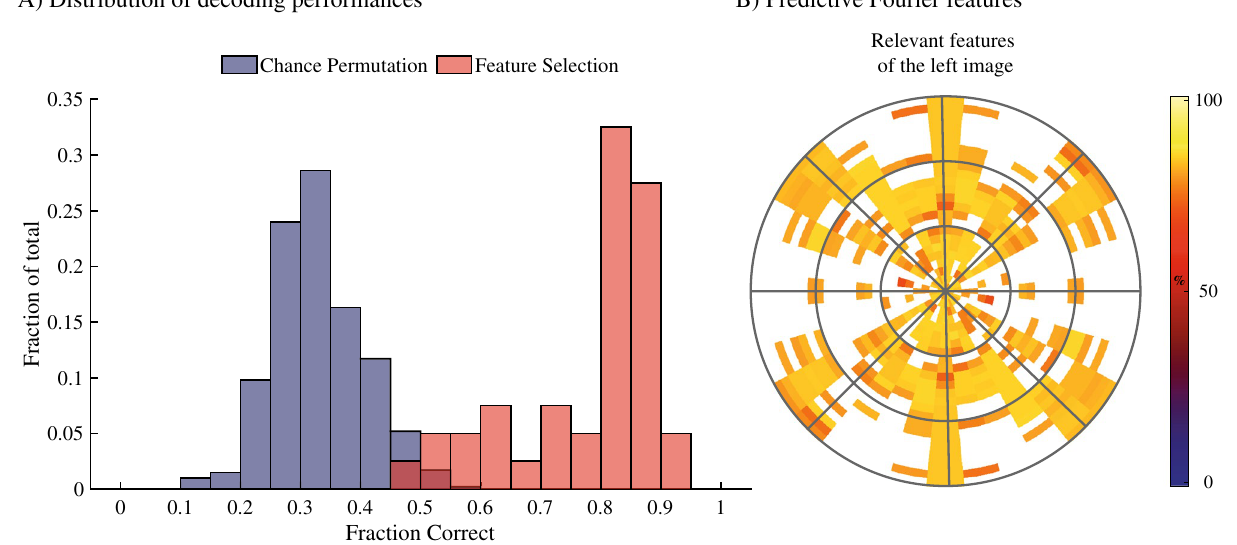
Figure 3. In ( A ) we show the pool of decoding performances for the feature selection and the control models. On the y-axis is the fraction of models that show a particular performance. Chance performances from the control models are shown in purple, performances of the feature selection models are shown in red. ( B ) The locations of the features that were shown significant for decoding within Fourier space. The coloured areas in the Fourier spaces show the location of the significant features with their colour reflecting their associated performances in percentage correct as shown in the colours on the right. While many orientation/spatial frequency combinations carry relevant information about the expression in the face, there is relatively little information along the horizontal axis, which reflects contrast in the vertical edges of the